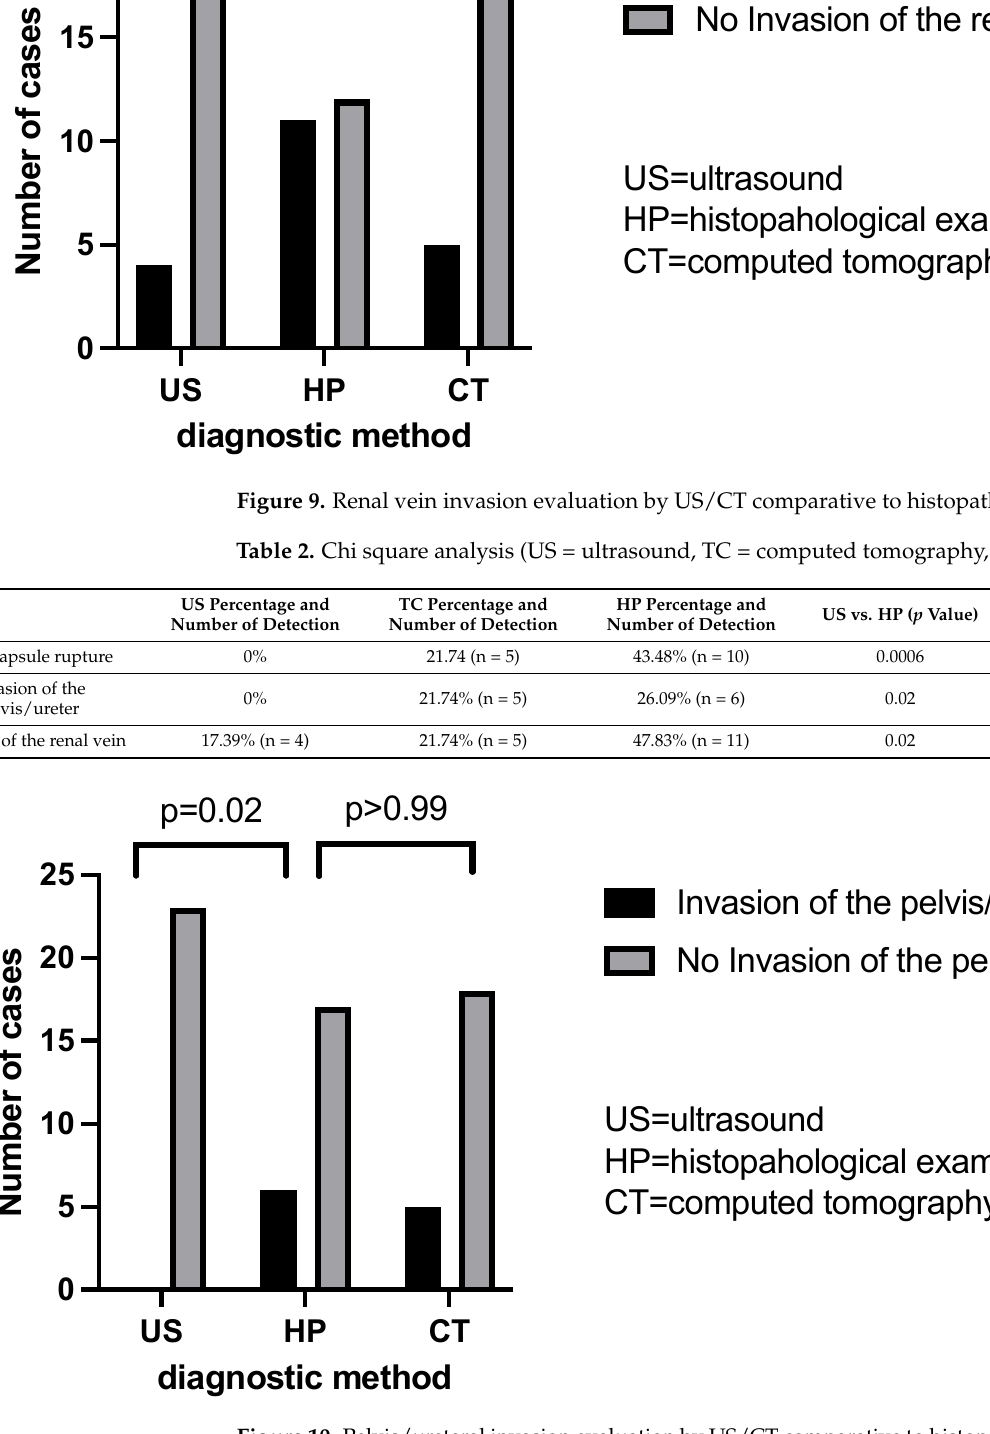
Figure 10. Pelvis/ureteral invasion evaluation by US/CT comparative to histopathological exami- nation.